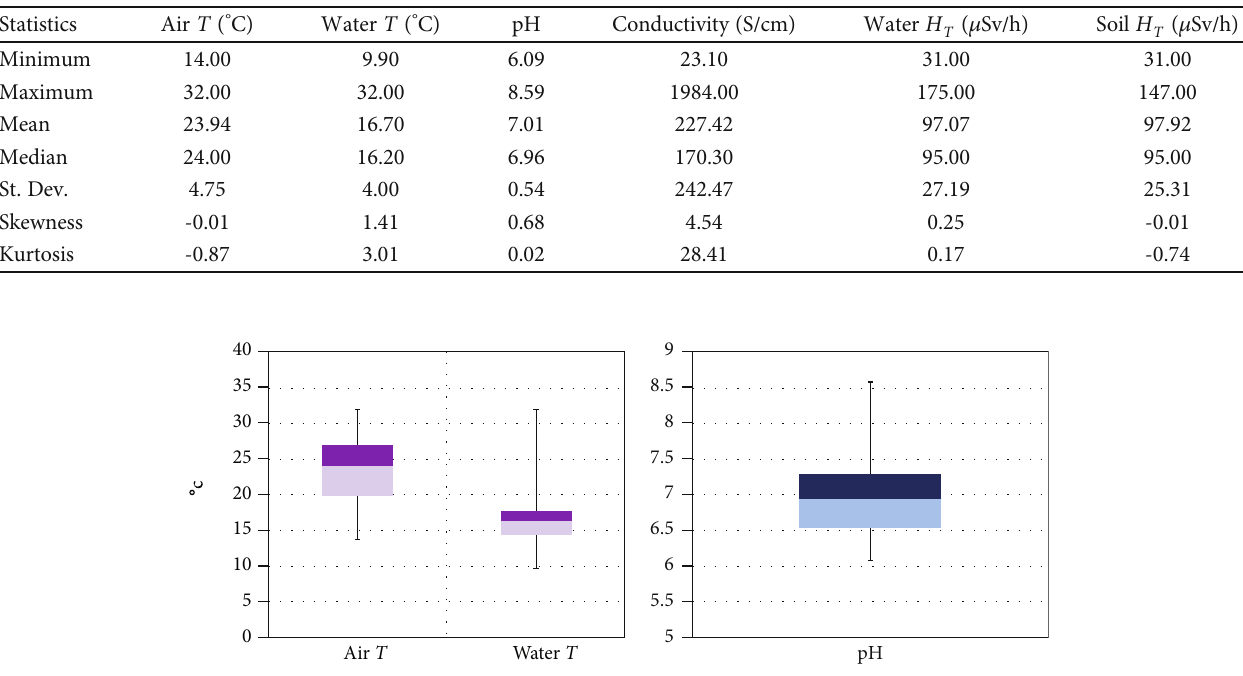
Table 2: Main descriptive statistics of the measured